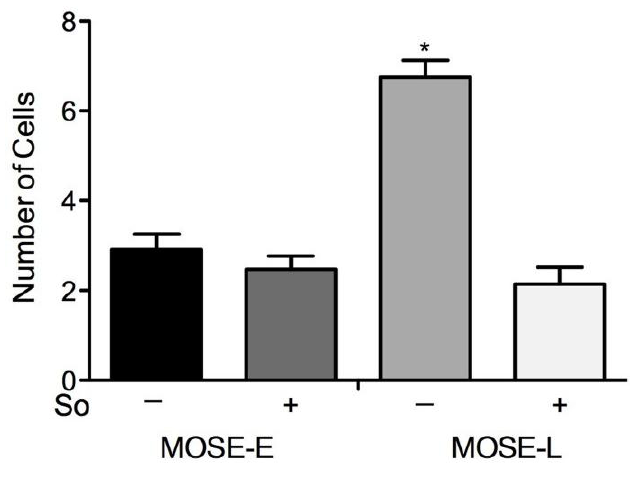
Figure 6. Suppression of invasion by Sph treatment. Number of cells able to invade matrigel afte r sphingosine (So) treatment. Date are presented as mean  SEM. * significantly different from MOSE-E, p <